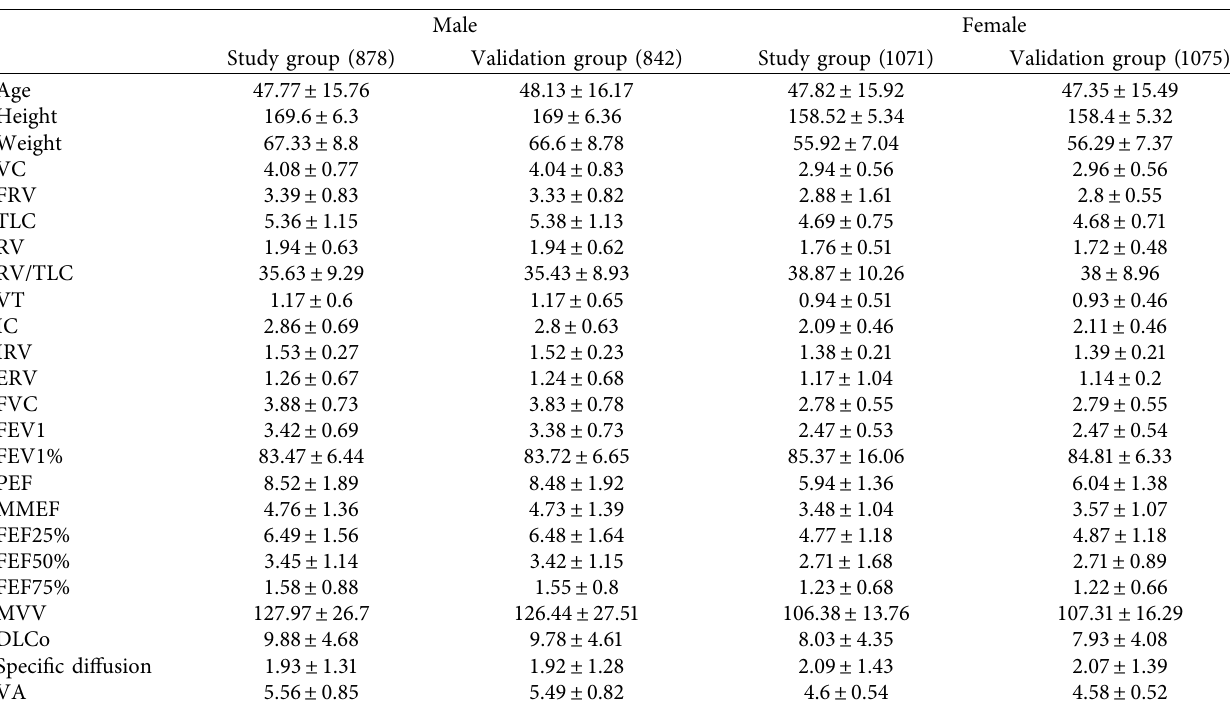
Table 2: Participants’ mean clinical